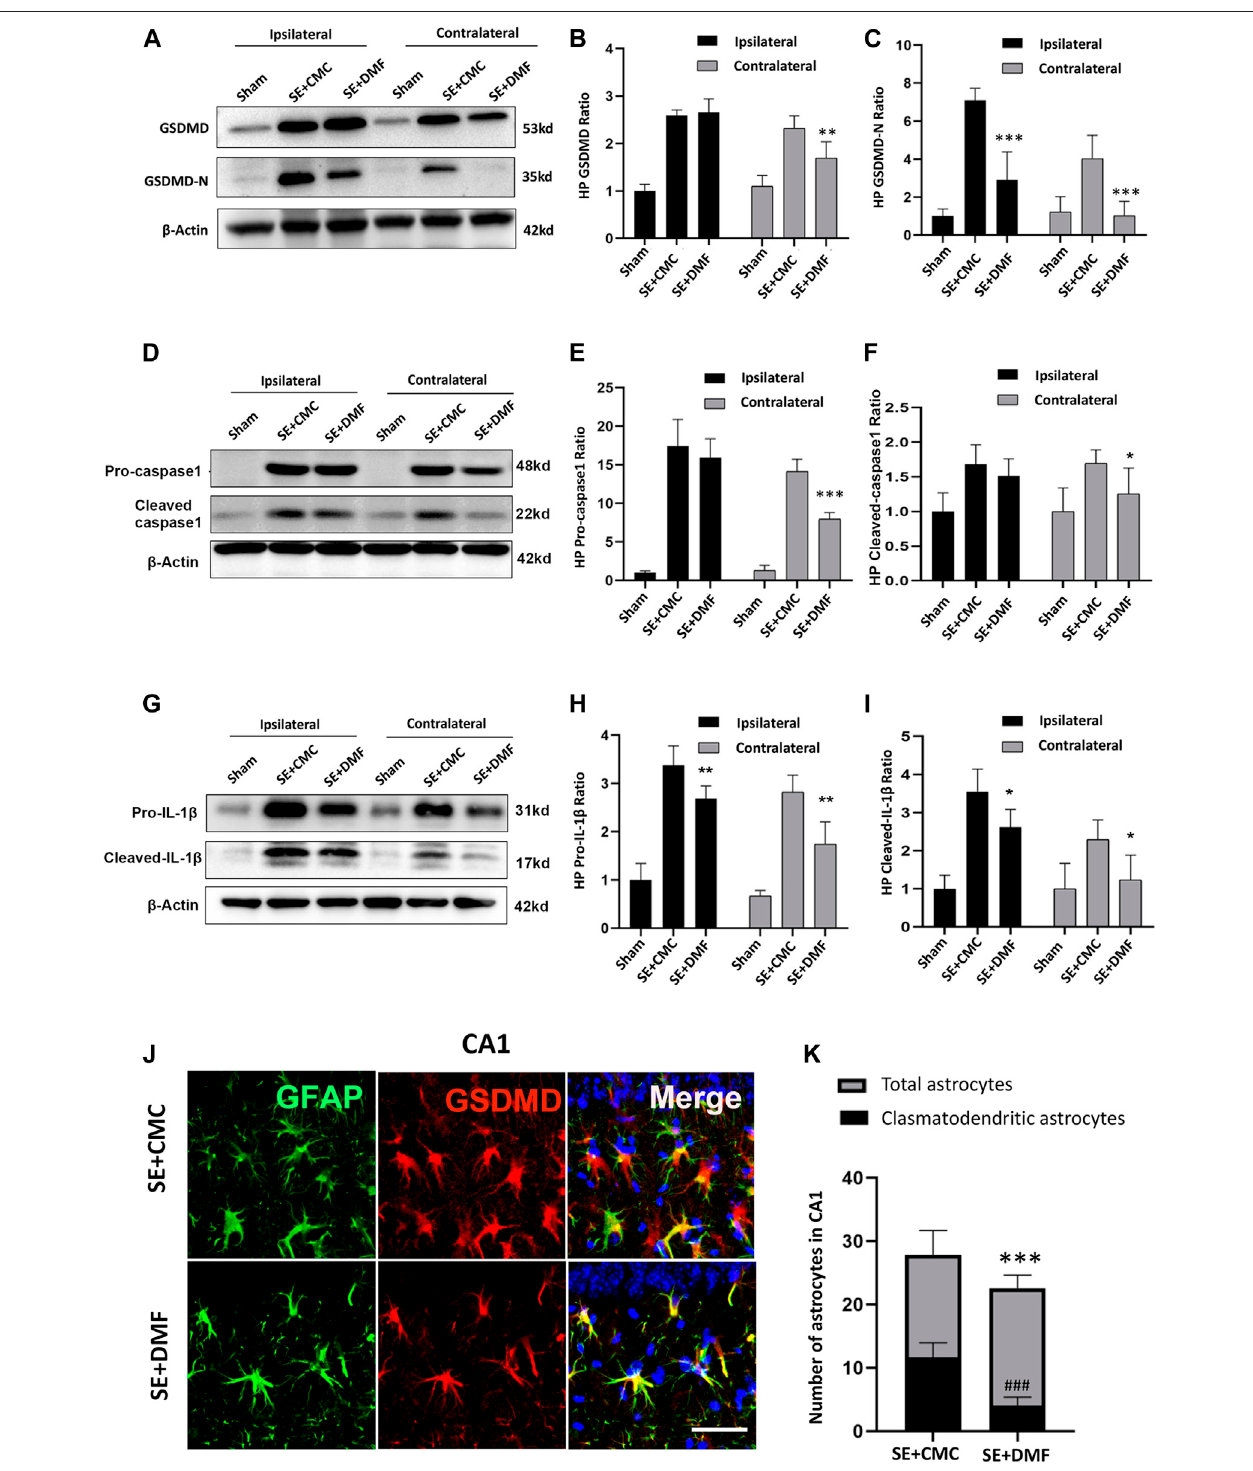
FIGURE 3 | DMF intervention inhibited the expression of GSDMD-N and attenuated astrocytic clasmatodendrosis. (A – C) WB bands and statistical analyses of GSDMD, GSDMD-N, and β -actin proteins in the ipsilateral and contralateral hippocampus in the SE + CMC and SE + DMF groups (n = 6 in each group, asterisks represent the comparison with the SE + CMC group, * p < 0.05, ** p < 0.01, and *** p < 0.001). (D – F) WB bands and statistical analyses of pro-caspase-1, cleaved- caspase1, and β -actin proteins in the ipsilateral and contralateral hippocampus (n = 6 in each group, asterisks indicate the comparison with the SE + CMC group,